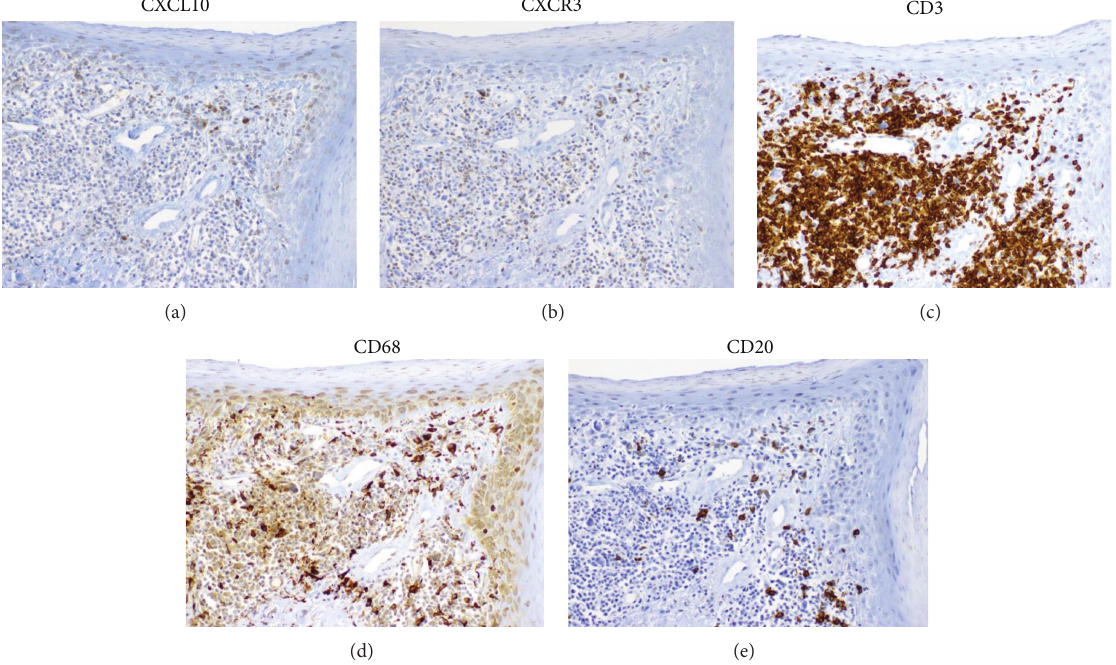
Figure 5: Serial sections of DLE lesional skin showed that CXCL10 (a) and CXCR3 (b) appeared to mirror the staining patterns of CD3 + T cells (c) and CD68 + (d) macrophages, but not CD20 + (e) B cells. Serial sections of DLE lesional skin were stained for CD3, CD20, CD68, CXCL10, and CXCR3. Magnification: